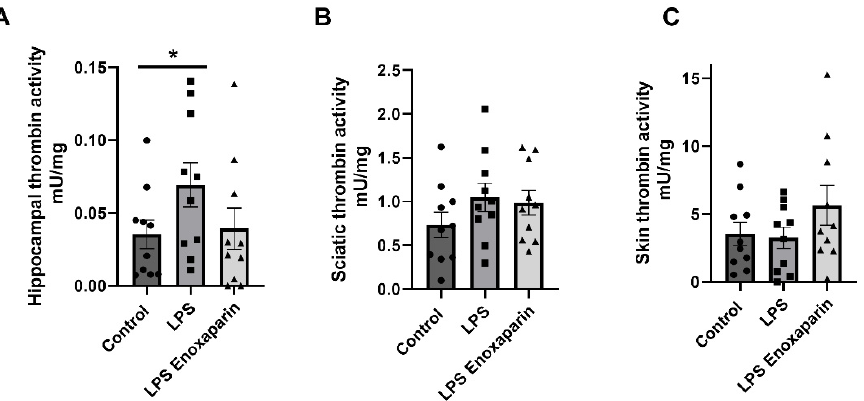
Figure 3. Thrombin activity levels in the hippocampus, sciatic nerve, and skin: ( A ) Thrombin activ- ity levels were significantly elevated in the LPS group compared to controls in the hippocampus. Enoxaparin treatment prevented hippocampal thrombin activity elevation. ( B ) Thrombin activity in